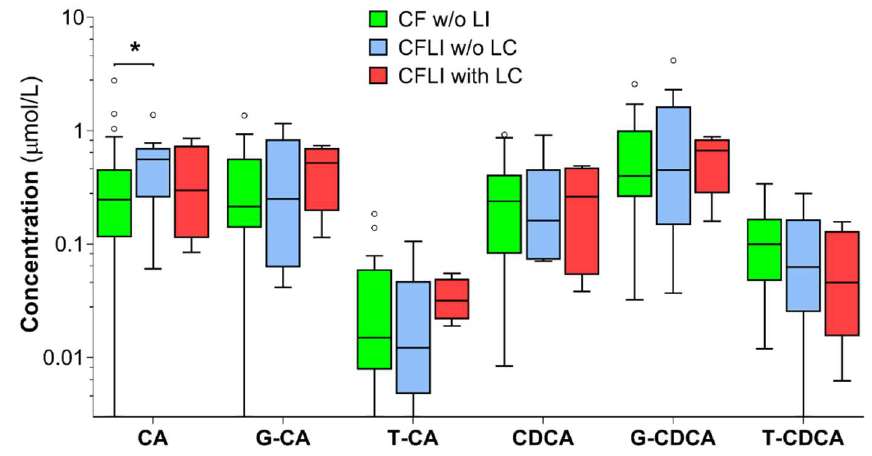
Figure 6. Serum primary bile acids distribution in the three subgroups classified according to pwCF’s CF-related liver involvement: cystic fibrosis without evidence of liver involvement (CF w / o LI) ( n = 32), cystic fibrosis-related liver involvement without cirrhosis (CFLI w / o LC) ( n = 10), and cystic fibrosis-related liver involvement with cirrhosis (CFLI with LC) ( n = 4). Circles represent data points above the value Q 3 + 1.5 × (Q 3 -Q1). * p = 0.036; CA: cholic acid; G-CA: glycocholic acid; T-CA: taurocholic acid; CDCA: chenodeoxycholic acid; G-CDCA: glycochenodeoxycholic acid; T-CDCA: taurochenodeoxycholic acid. Table 6. Serum bile acids distribution in different subgroups classified according to CF-related liver involvement (median and [Q 1 , Q 3 ]).